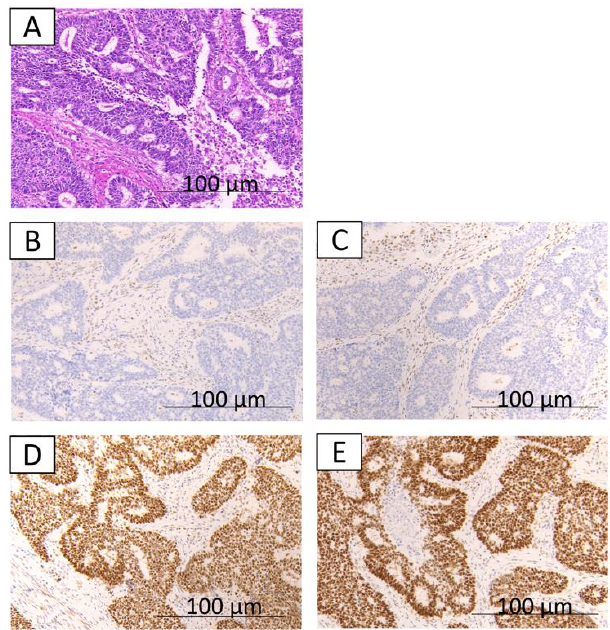
Figure 1. The immunohistochemical findings from case 1. A,B,C,D,E : well-differentiated component; hematoxylin and eosin staining show well-differentiated endometrioid glands ( A ); loss of expression of MLH1 ( B ); loss of expression of PMS2 ( C ); expression of MSH2 ( D ); expression of MSH6 ( E ).